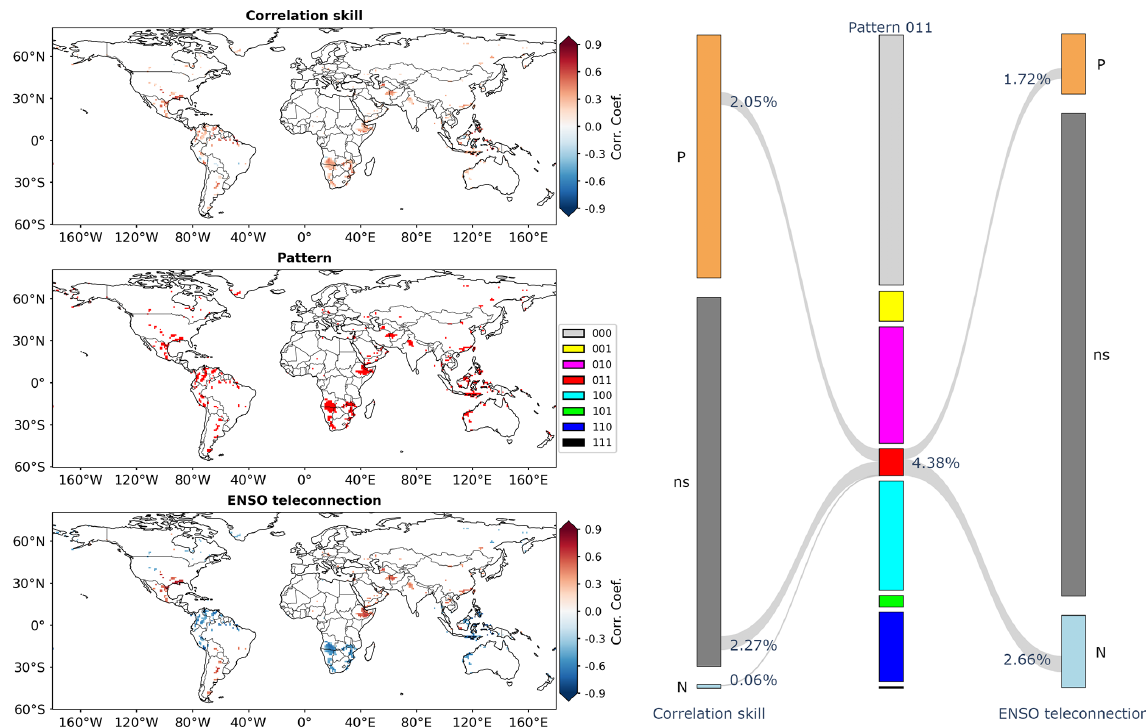
Figure 8. As for Fig. 4 but for pattern 011.